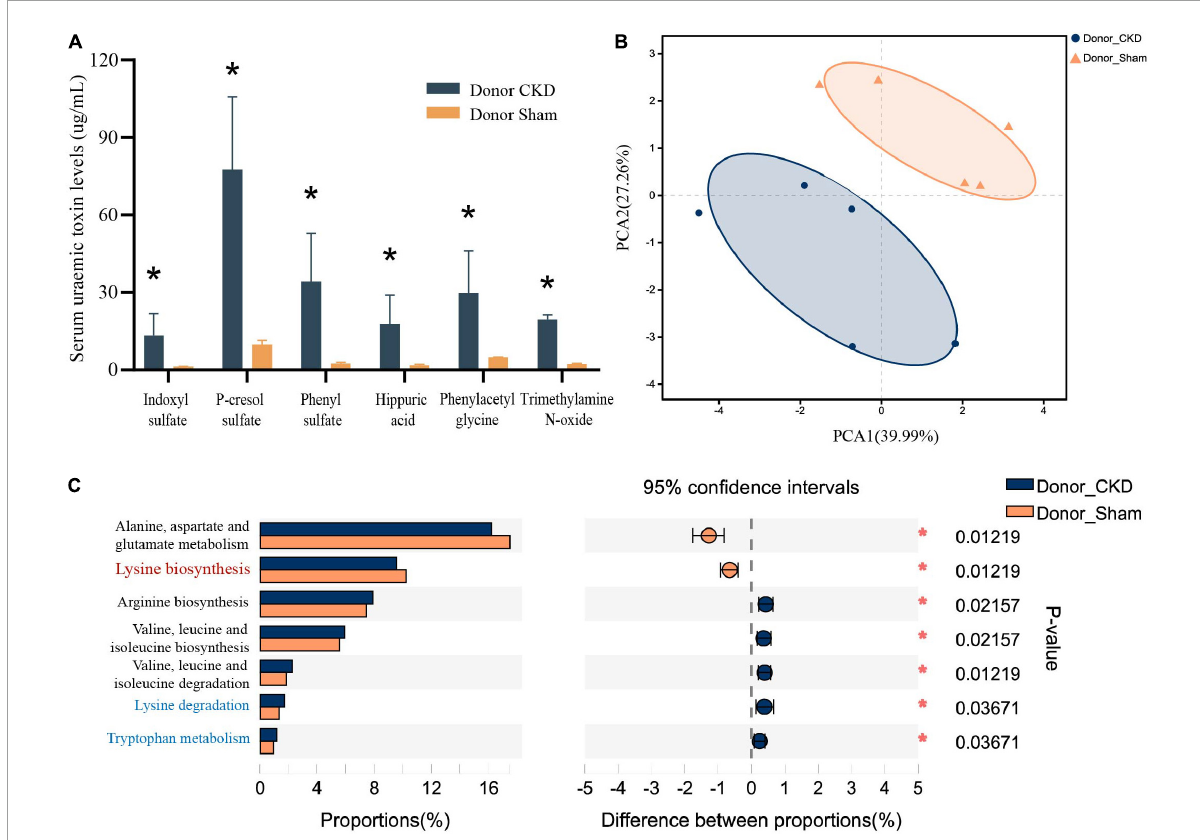
FIGURE4 Differences in bacterial amino acid metabolism associated with the KEGG database between Donor CKD and Donor Sham rats. (A) PBUTs levels after successful establishment of a kidney disease model. (B) PCA plots of amino acid metabolism expression (PERMANOVA P < 0.05). (C) Differential amino acid metabolism pathways in gut microbiota (Wilcoxon rank sum test). The vertical coordinates indicate the KEGG function names at different classification levels, and the horizontal coordinates indicate the percentage value of a particular KEGG function abundance for that sample, with different colors indicating different groupings. Donor Sham, n = 5; Donor CKD, n = 5. * P <